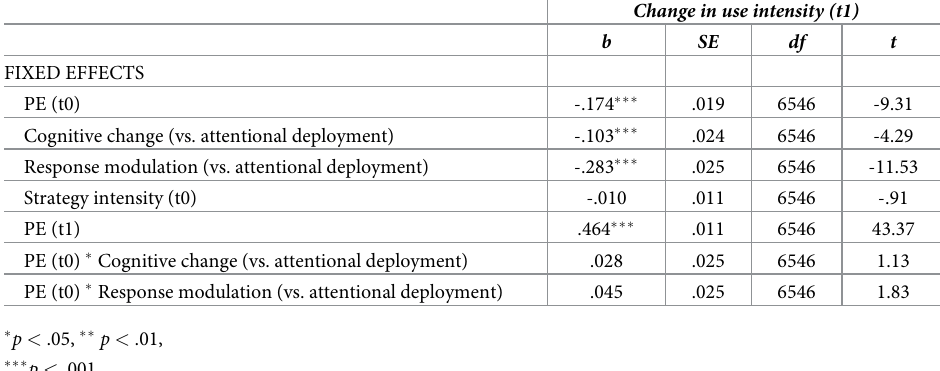
Table 4. Results of the linear mixed-effect model predicting the effect of positive emotions at t0 on change in strategy intensity at t1, moderated by strategy category. Change in use intensity (t1) b SE df t FIXED EFFECTS PE (t0) -.174 ��� .019 6546 -9.31 Cognitive change (vs. attentional deployment) -.103 ��� .024 6546 -4.29 Response modulation (vs. attentional deployment) -.283 ��� .025 6546 -11.53 Strategy intensity (t0) -.010 .011 6546 -.91 PE (t1) .464 ��� .011 6546 43.37 PE (t0) � Cognitive change (vs. attentional deployment) .028 .025 6546 1.13 PE (t0) � Response modulation (vs. attentional deployment) .045 .025 6546 1.83